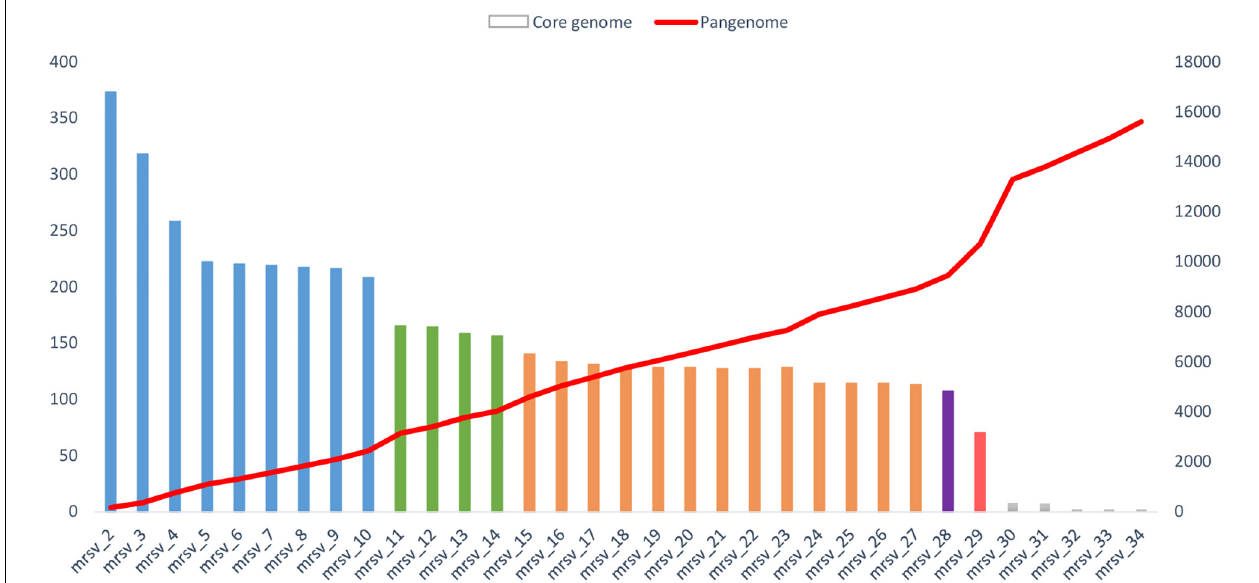
FIGURE 4 | Evolution of the size of the core genome and pangenome of marseilleviruses. The analysis was made by a reciprocal best BLAST hit strategy with significant thresholds for amino acid identity and coverage of 30 and 70%, respectively. The core genome is represented by the histogram column. Each lineage is labeled by a specific color: blue for lineage A, green for lineage B, orange for lineage C, purple for lineage D, and red for lineage E. The pangenome is highlighted by the red curve. The order for inclusion of each marseillevirus in the analysis corresponds to the order shown in Supplementary Table 1 , as follows: mrsv_2: Cannes 8 virus; mrsv_3: Melbournevirus; mrsv_4: Tokyovirus A1; mrsv_5: Senegalvirus; mrsv_6: Phoenicianvirus; mrsv_7: Marseillevirus G648; mrsv_8: Marseillevirus G649; mrsv_9: Marseillevirus G650; mrsv_10: Marseillevirus Shangai 1; mrsv_11: Lausannevirus; mrsv_12: Noumeavirus; mrsv_13: Port-miou virus; mrsv_14: Kurlavirus BKC-1; mrsv_15: Tunisvirus; mrsv_16: Insectomime virus; mrsv_17: Marseillevirus N1; mrsv_18: Marseillevirus N16; mrsv_19: Marseillevirus N36; mrsv_20: Marseillevirus N40; mrsv_21: Marseillevirus N50; mrsv_22: Marseillevirus N57; mrsv_23: Marseillevirus N60A; mrsv_24: Marseillevirus N60B; mrsv_25: Marseillevirus NAQ2; mrsv_26: Marseillevirus AM2; mrsv_27: Marseillevirus AM21; mrsv_28: Brazilian marseillevirus; mrsv_29: Golden marseillevirus; mrsv_30: Marseillevirus LCMAC 101; mrsv_31: Marseillevirus LCMAC 102; mrsv_32: Marseillevirus LCMAC 103; mrsv_33: Marseillevirus LCMAC 201; mrsv_34: Marseillevirus LCMAC